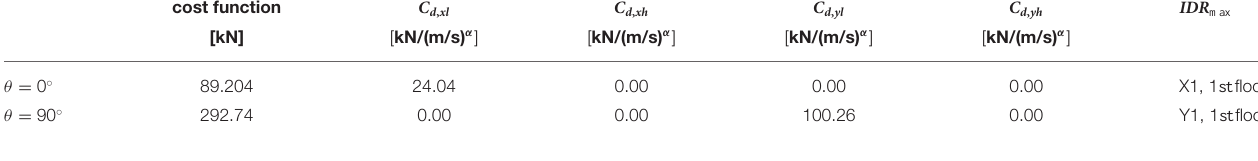
TABLE 4 | Cost function and characteristic parameters for optimal configurations.